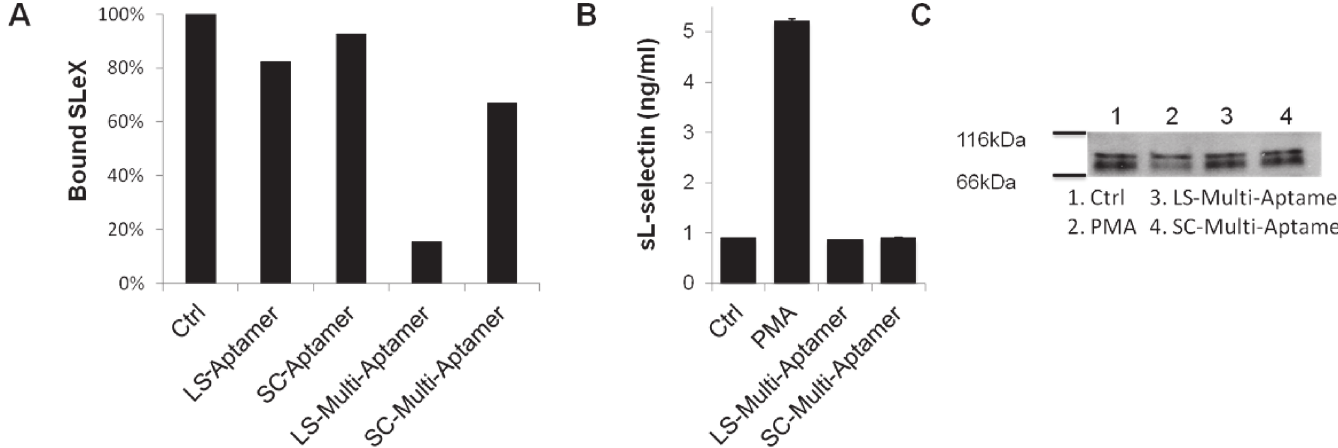
Fig 6. LS-Multi-Aptamer blocks binding to endogenous ligands without inducing shedding. (A) Relative percentage of bound SLeX following incubation of Jurkat cells with the indicated monovalent aptamers and Multi-Aptamers. (B) ELISA quantification of shed L-selectin following treatment of Jurkat cells with the indicated Multi-Aptamers or PMA. (C) Western blot analysis of Jurkat cell-associated L-selectin following the indicated treatments. Error bars are SEM.